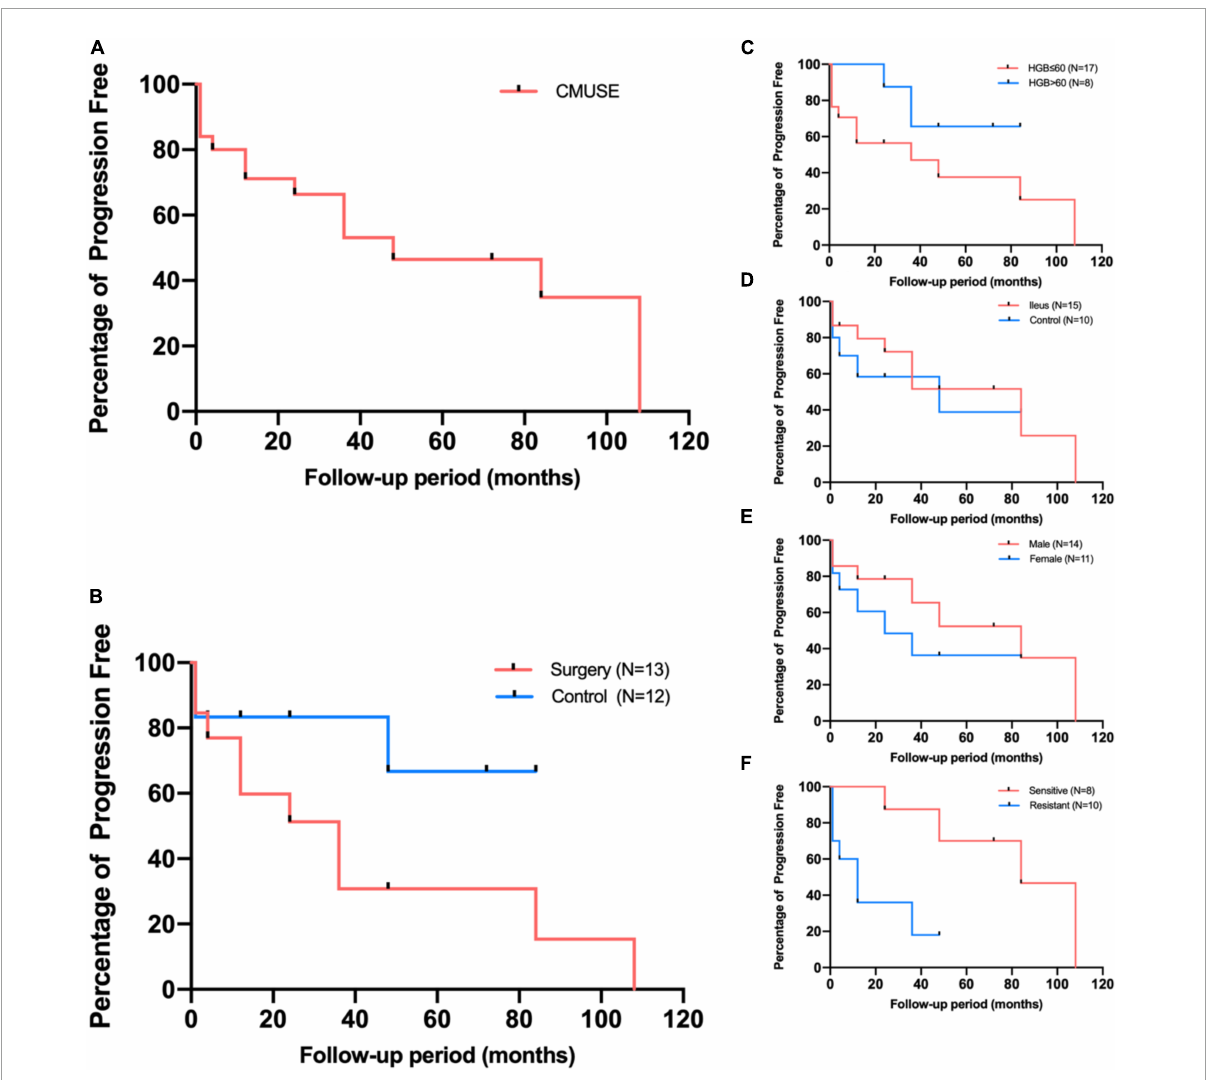
FIGURE2 Kaplan-Meier estimates for patients free from progression (A) , and subgroup analyses according to surgery (B) , presenting manifestations (C,D) , gender (E) , and corticosteroids response (F)